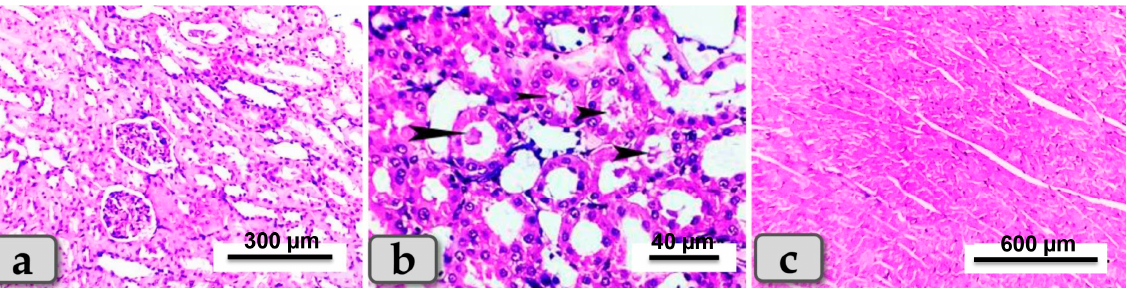
Figure 8. Photomicrographs of kidneys and hearts from rats suffering diabetes and treated with both SeNPs and BV (group 5). ( a ) Showing renal cortex of apparently normal, intact renal tubules and renal glomeruli. ( b ) Showing a few infiltrations of casts in some renal tubules of renal medulla (arrow head) and normal intact tissue. ( c ) Showing apparently normal and intact cardiac myocytes.